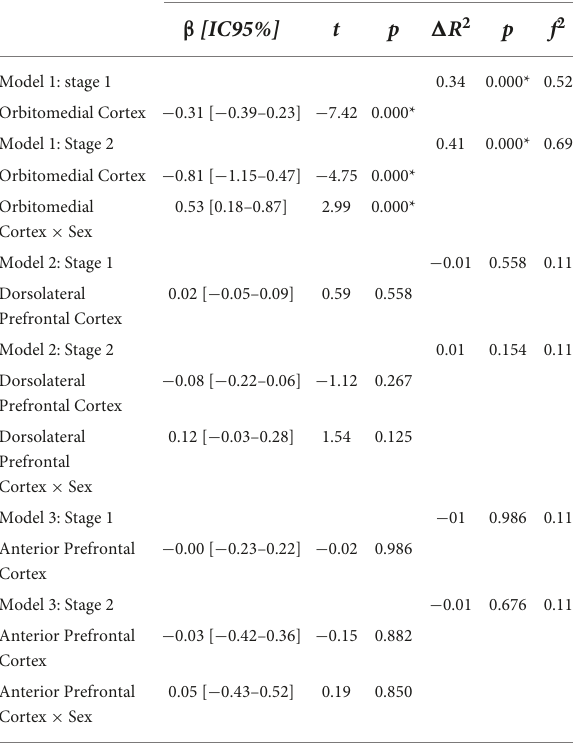
TABLE 3 Model of the moderating effect of sex in the relationship of the